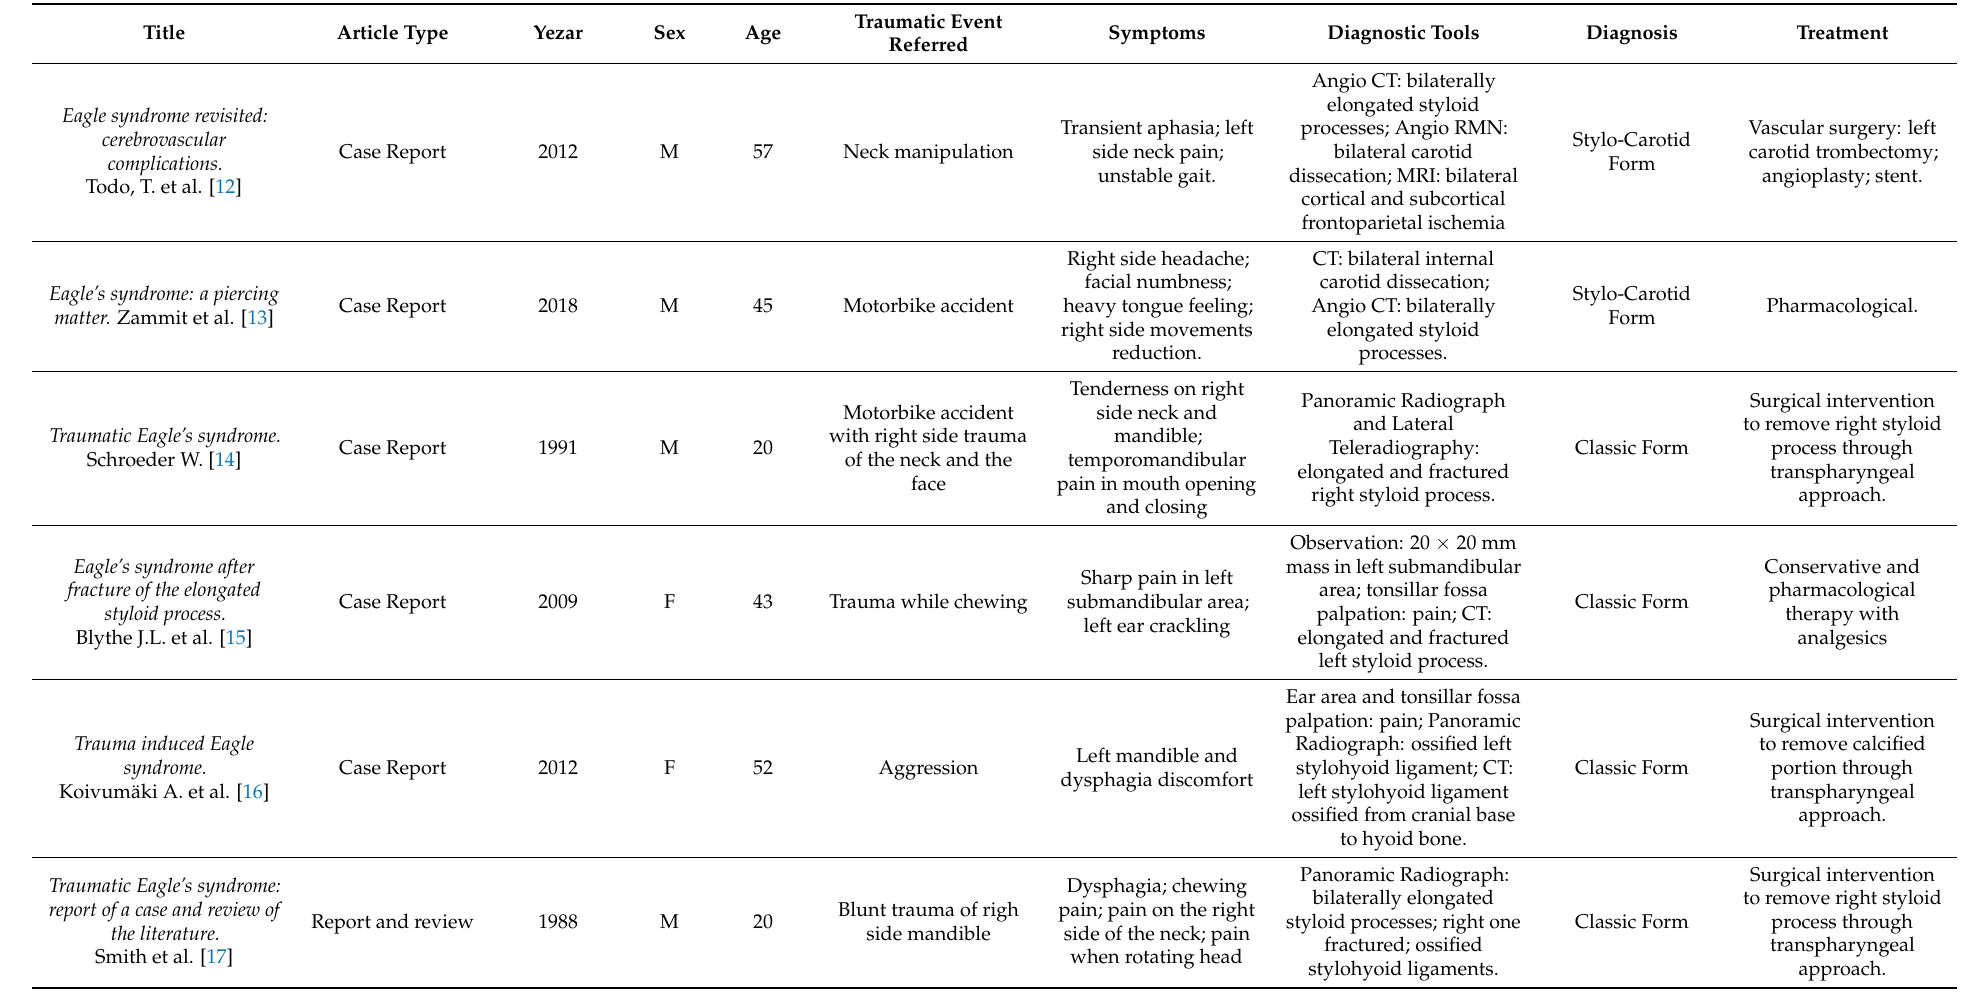
Table 3. Summarized correlation between Eagle Syndrome and traumatic